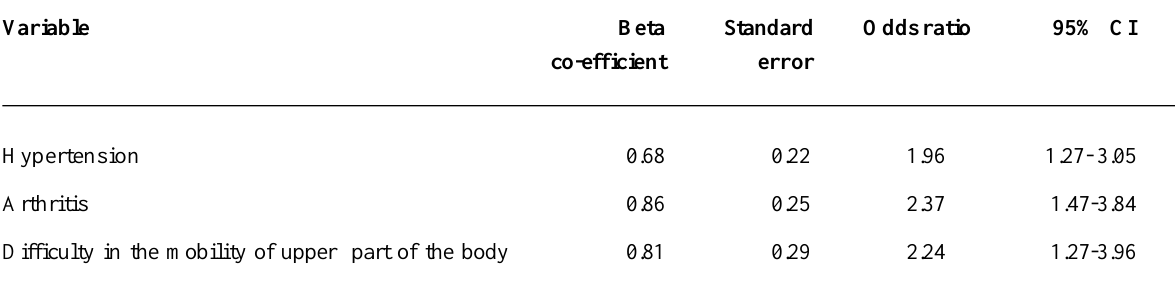
Table 4. Adjusted odds ratio for occurrence of home